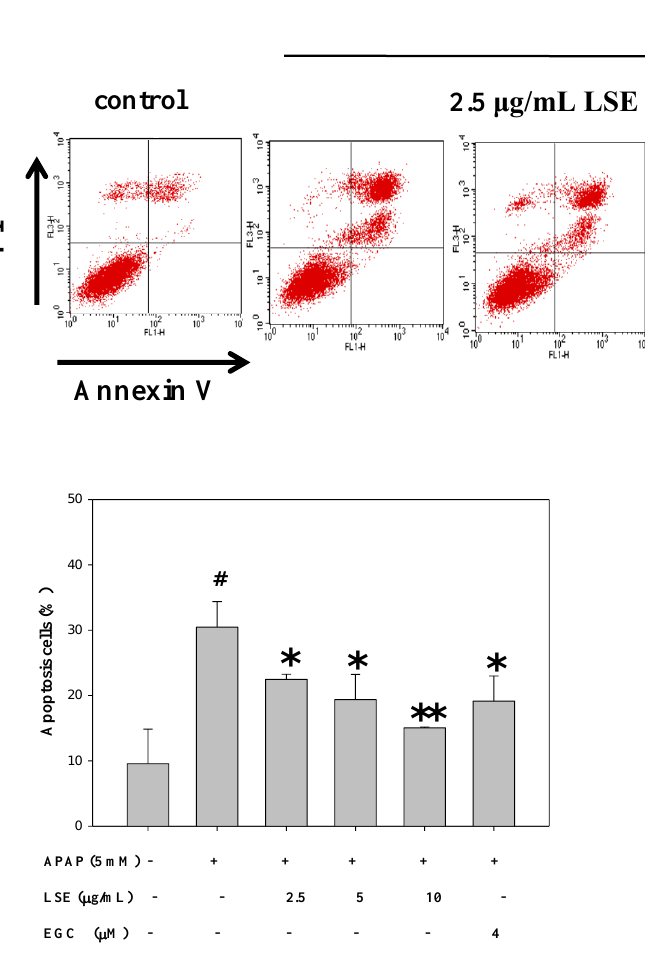
Figure 2. Effect of APAP with/without LSE (2.5, 5, and 10 µg/mL) or EGC (4 µM) on ( A ) intracellular ROS levels and ( B ) the cellular morphology was stained by DAPI. Apoptotic nuclei are indicated by arrows. Apoptotic values are presented as percentage of apoptotic cells divided by total number of cells. ( C ) The apoptosis rate of HepG2 cells analyzed by flow cytometry with annexin V/PI double staining after treating LSE or EGC with or without APAP for 24 h. Upper right zone indicates the late stage of apoptotic cells (Annexin V and PI positive). All data were presented as means ± SD of three independent experiments. # p < 0.05, ## p < 0.01 compared with the control group. * p < 0.05, ** p < 0.01 compared with the APAP group.